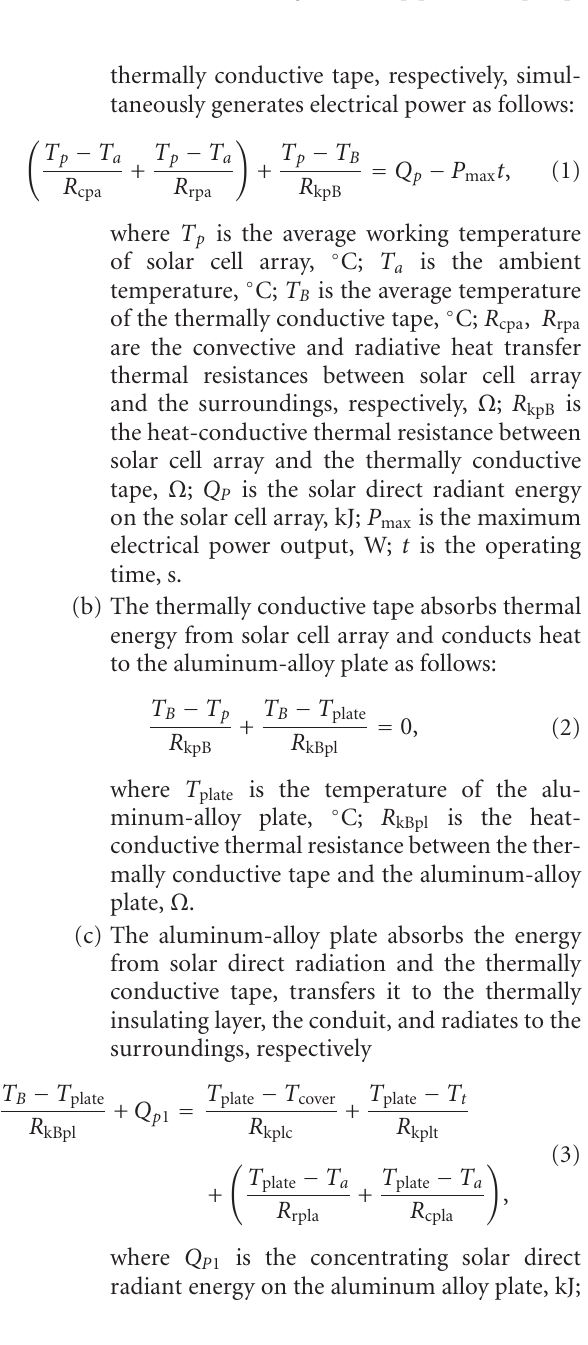
Figure 1: The configuration of the TCPV/T system. (1) Trough concentrator, (2) receiver, (3) storage tank, (4) pipe, and (5)